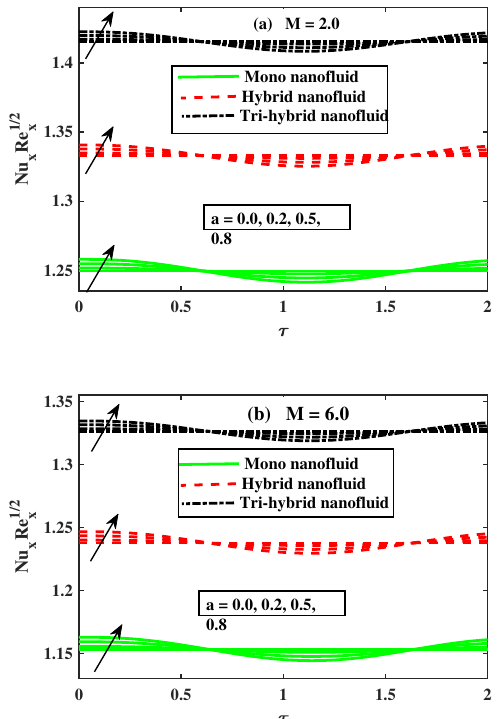
Figure 9. ( a ) Fluctuation of M on Nu x Re 1/2 x ; ( b ) Fluctuation of M on Nu x Re 1/2 x .